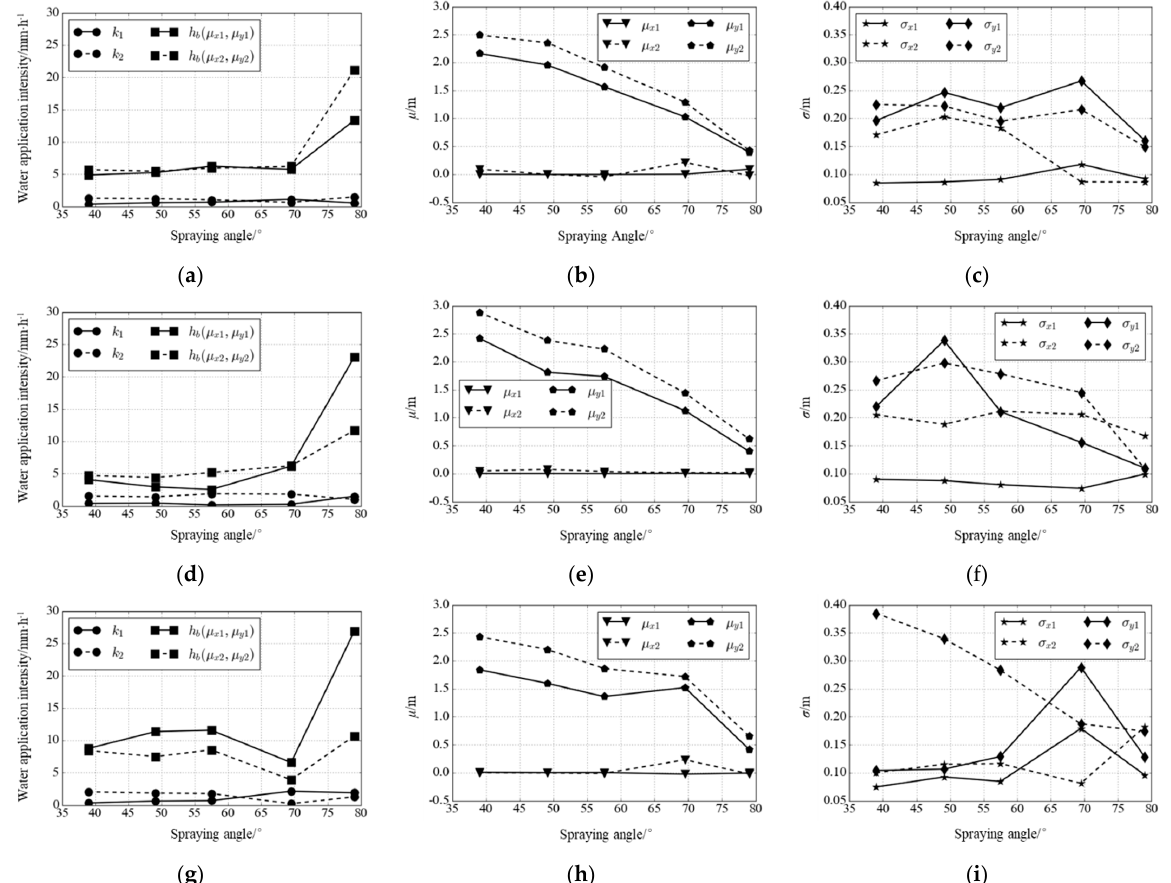
Figure 8. Fitting parameters of water application intensity on the individual orifice a 3-6 under different spraying angles: ( a ) k and peak value at 41 kPa; ( b ) μ x and μ y at 41 kPa, ( c ) σ x and σ y at 41 kPa, ( d ) k and peak value at 69 kPa; ( e ) μ x and μ y at 69 kPa, ( f ) σ x and σ y at 69 kPa, ( g ) k and peak value at 103 kPa; ( h ) μ x and μ y at 103 kPa and ( i ) σ x and σ y at 103 kPa. Notes: k 1 and k 2 were used to quantify the effects of the two unimodal peaks on the bimodal distribution. h b ( μ x 1 , μ y 1 ) and h b ( μ x 2 , μ y2 ) are two peak values. μ x 1 and μ x 2 are the peak locations near and far away from an individual orifice in x direction . μ y 1 and μ y 2 are the peak locations near and far away from an individual orifice in y direction . σ x 1 and σ x 2 are the dispersion degrees of water distribution near and far away from an individual orifice in x direction; σ y 1 and σ y 2 are the dispersion degrees of water distribu- tion near and far away from an individual orifice in y direction .